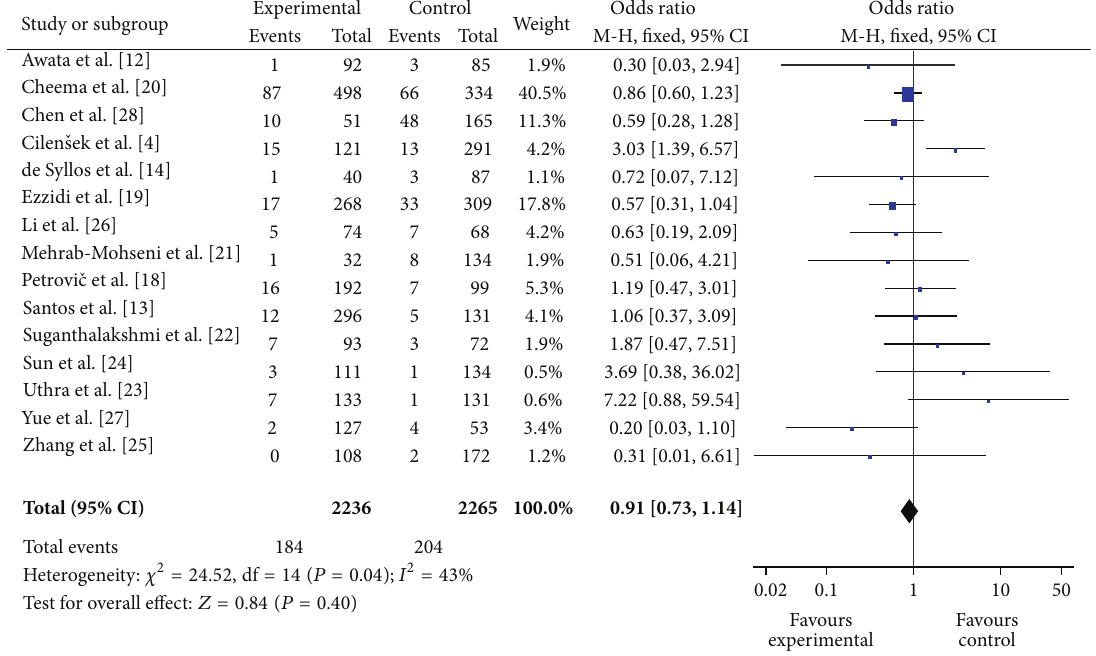
with the risk of diabetic retinopathy. The results indicated that the eNOS 4b/a polymorphism was not associated with an increased risk of DR in the overall studied